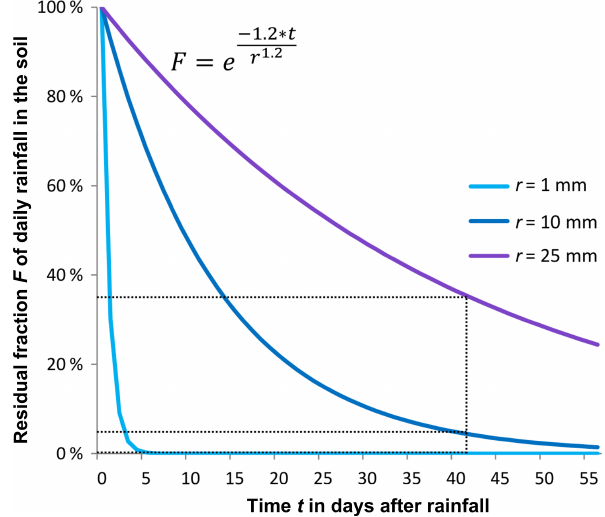
Figure 3. Decay curves for three daily rainfalls of 1, 10 and 25mm according to the expression of the exponential filter function in Eq. (2), with a = 1 . 2 and b = 1 . 2. The black dotted lines show that 0%, 4.2% and 34.7% of the respective original rainfall values are still contributing to the accumulated antecedent rainfall function (Eq. 2) after 42d (6